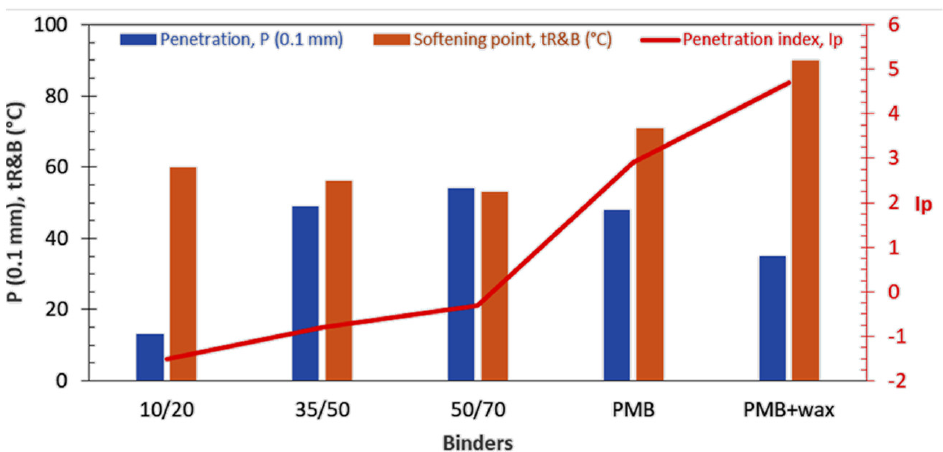
Figure 8. Consistency and thermal susceptibility of the evaluated binders.